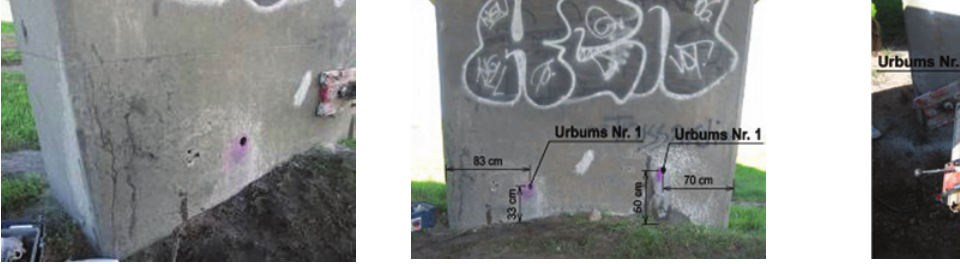
fig. 9. Core sampling from the ramp No. 8 pier